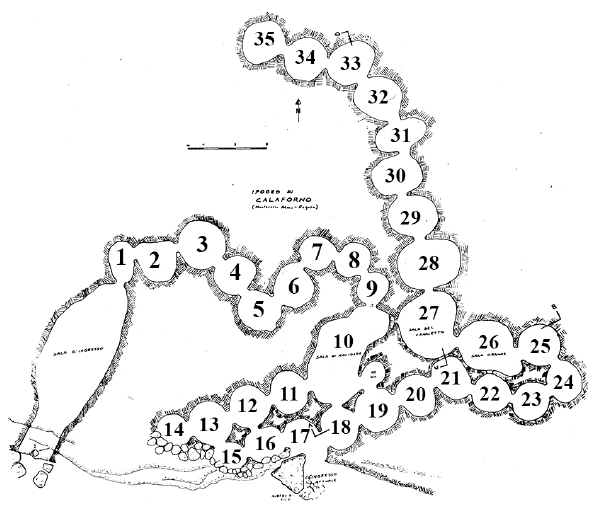
Figure 3 . The hypogeum of Calaforno (first survey by Guzzardi